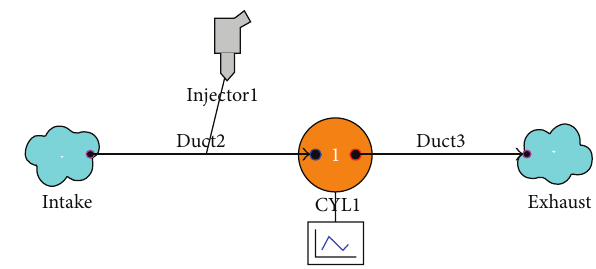
Figure 6: Engine model designed with